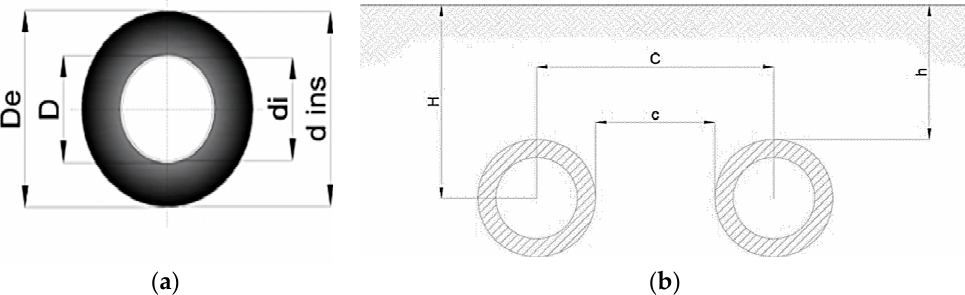
Figure 7. ( a ) Pipes Diameters; D = Pipe external diameter; di = Pipe internal diameter; De = Waterproof case external diameter; d ins = Insulating external diameter, ( b ) Pipes position.